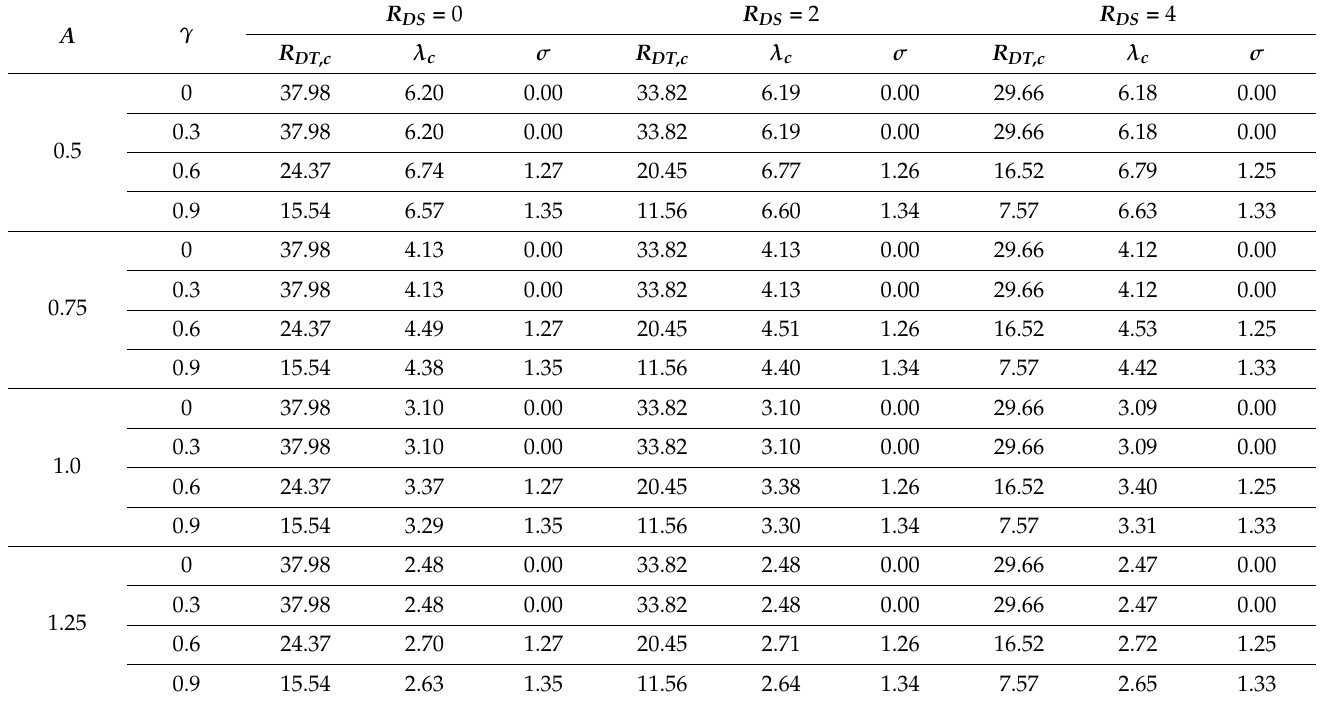
Table 4. Comparison of R DT , c , λ c , and σ for diverse values of γ , A , and R DS at Le = 2, m =